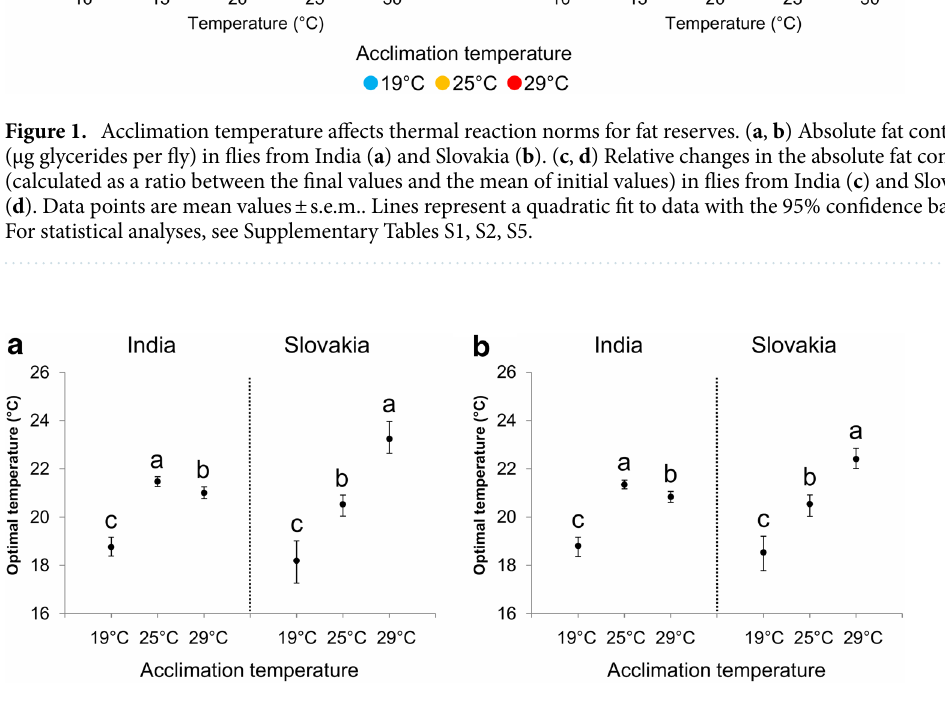
Figure 2. The optimal temperatures for fat reserves estimated based on ( a ) the absolute fat content (µg glycerides per fly), and ( b ) the relative changes in the absolute fat content. Error bars represent 95% confidence intervals. Values with different letters are significantly different from each other (α =